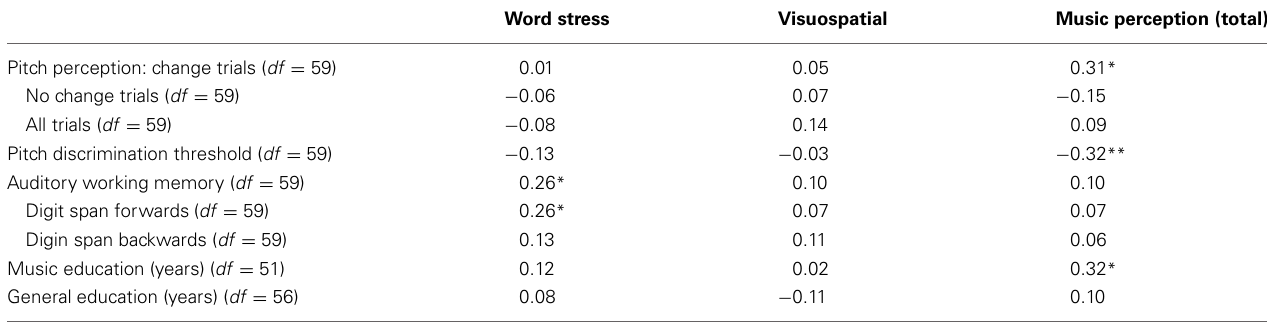
Table 7 | Correlations between speech prosody and visuospatial perception, music perception and possible confounding variables. Word stress